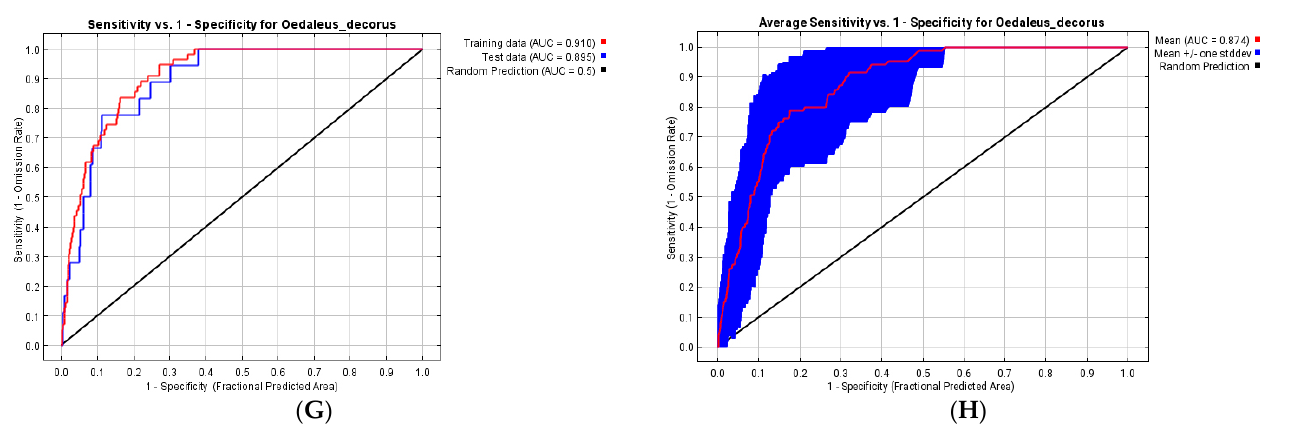
Figure 6. Reliability tests of the Oedaleus decorus distribution models for the south-eastern part of the West Siberian Plain: ( A , B )—distribution data before 1961 and bioclimatic variables for 1970–2000; ( C , D )—distribution data from 1961 until 2021 and bioclimatic variables for 1970–2000; ( E , F )—distribution data from 1961 until 2021 and forecasts of bioclimatic variables from the climatic model CNRM-ESM2-1 ( G , H )—distribution data from 1961 until 2021 and forecasts of bioclimatic variables from the climatic model MIROC6; ( A , C , E , G )—for training and test (25%) data; ( B , D , F , H )—for 20 replicates with cross-validation.